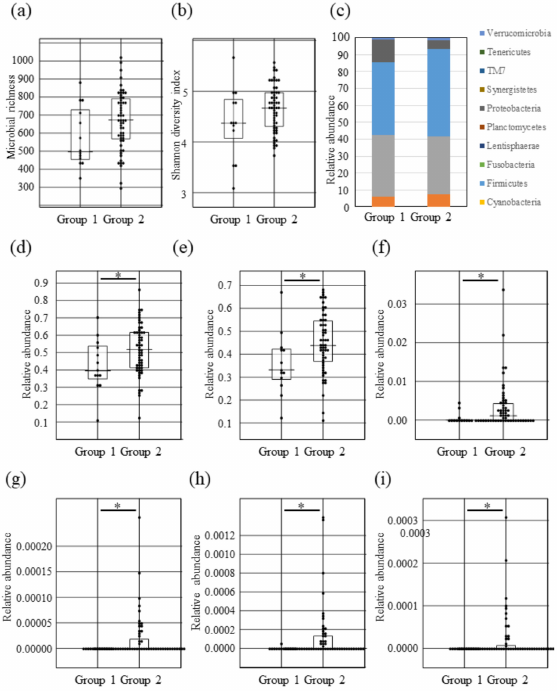
Figure 2. Comparison of the fecal microbial diversity and microbial taxonomic change of the fecal microbiota between the oral lantibiotic producer positive (group 1) and negative (group 2) subjects. Microbial richness ( a ) and Shannon diversity ( b ) based on operational taxonomic units (OTUs). The boxplots represent the diversity measures for 13 subjects (the lantibiotic positive group: Group 1) and 56 subjects (the lantibiotic negative group: Group 2). ( c ) Comparison of relative abundance of OTUs in bacterial composition of the fecal samples at phylum level between the lantibiotic positive group (Group 1; n = 13) and negative group (Group 2; n = 56). Relative abundance based on OTUs ( d ) or quantitative Real-time PCR ( e ) in Firmicutes of the fecal samples between groups. Relative abundance based on OTUs in genus Anaerostipes ( f ), ph2 ( g ), Holdemania ( h ), or cc-115 ( i ) in the fecal samples between groups. All of the boxplots for each group represent the interquartile range (25–75%) and the line within the box represents the median value. Mann-Whitney U-tests were used to test for significant differences between sample distances and asterisks show significant differences ( p <